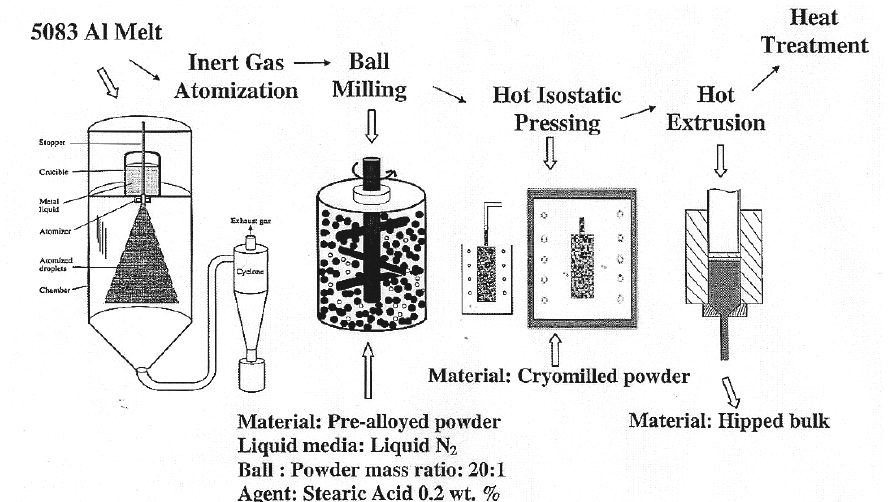
Figure 15. Cryomilling followed by consolidation and